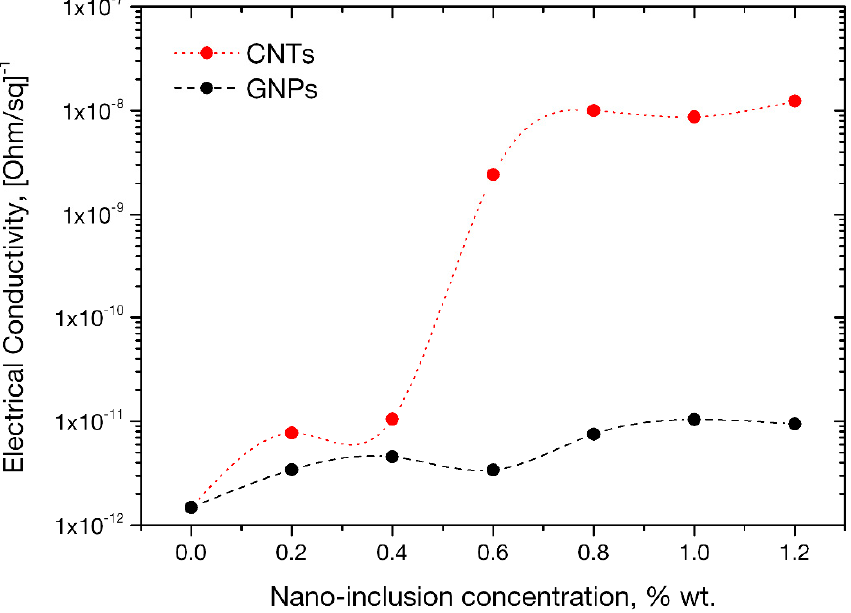
Figure 10. Surface electrical conductivity variation with CNT and GNP concentration.